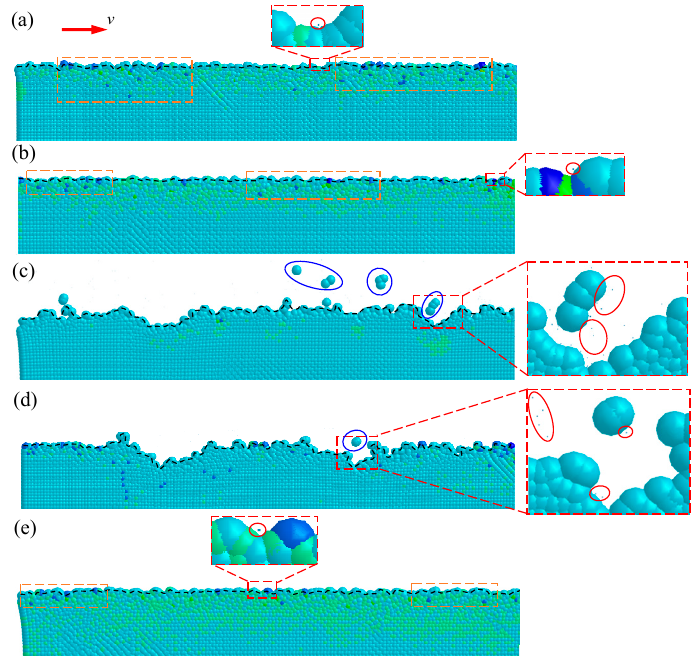
Figure 9. Machined surface in the cutting simulations of different types of cutting edge: ( a ) sharp edge with r n = 30 nm; ( b ) blunt edge with r n = 60 nm; ( c ) crescent edge; ( d ) flat edge A; ( e ) flat edge B (with the same stress legend of Figure 8).